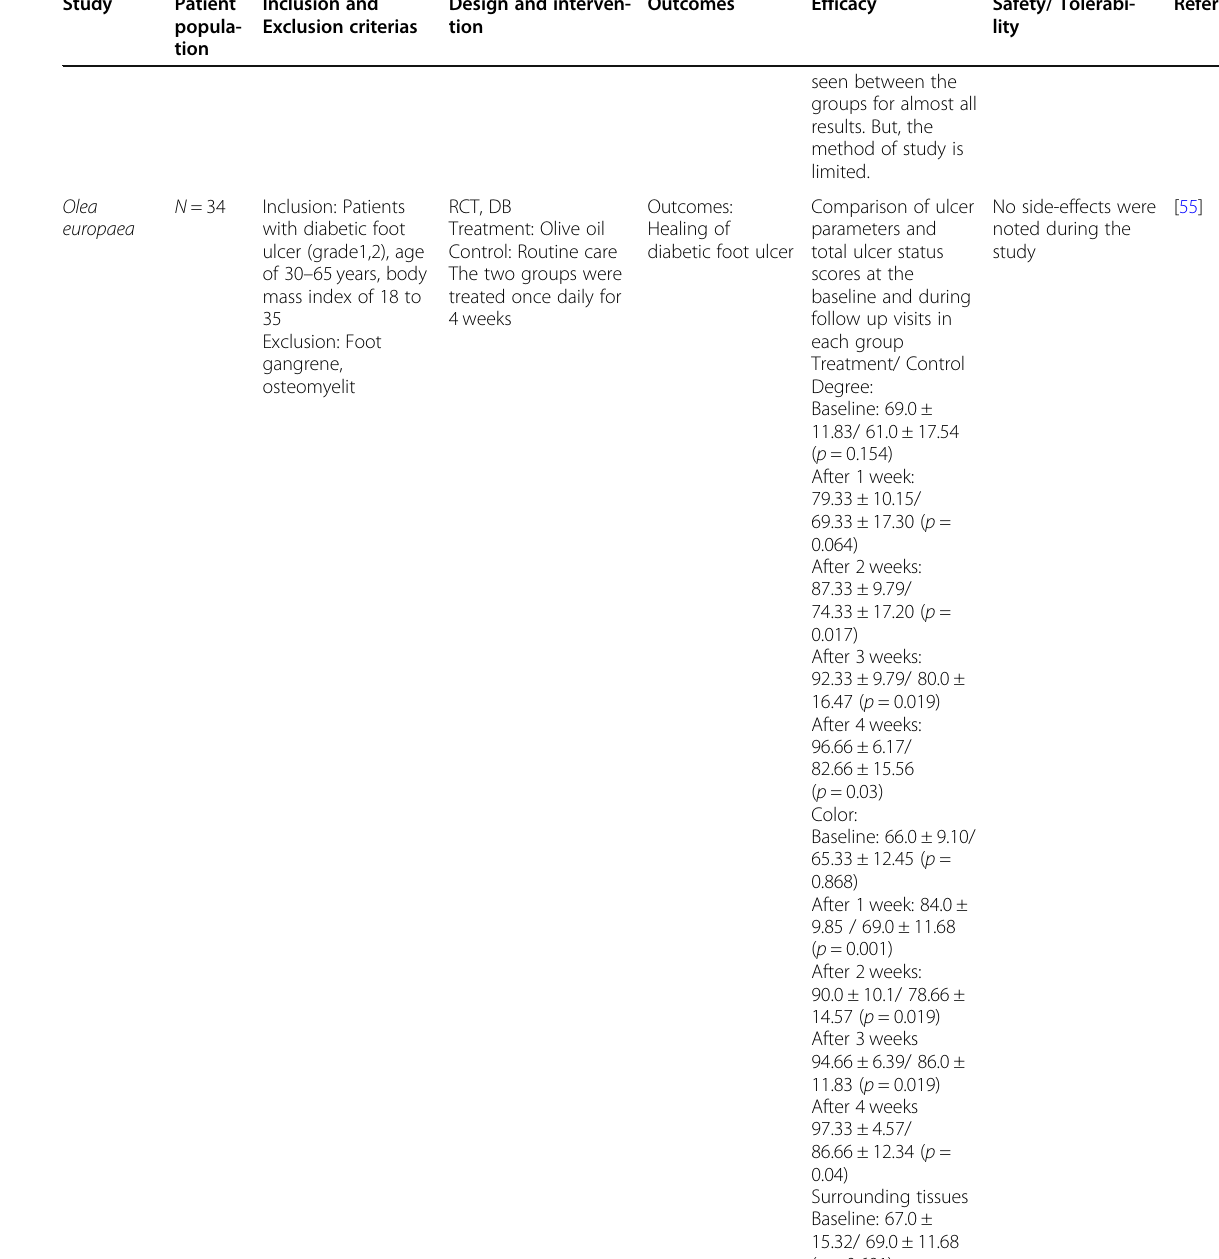
Table 4 Clinical trials of the traditional plants used for skin problems in Turkey (Continued) Study Patient popula- tion